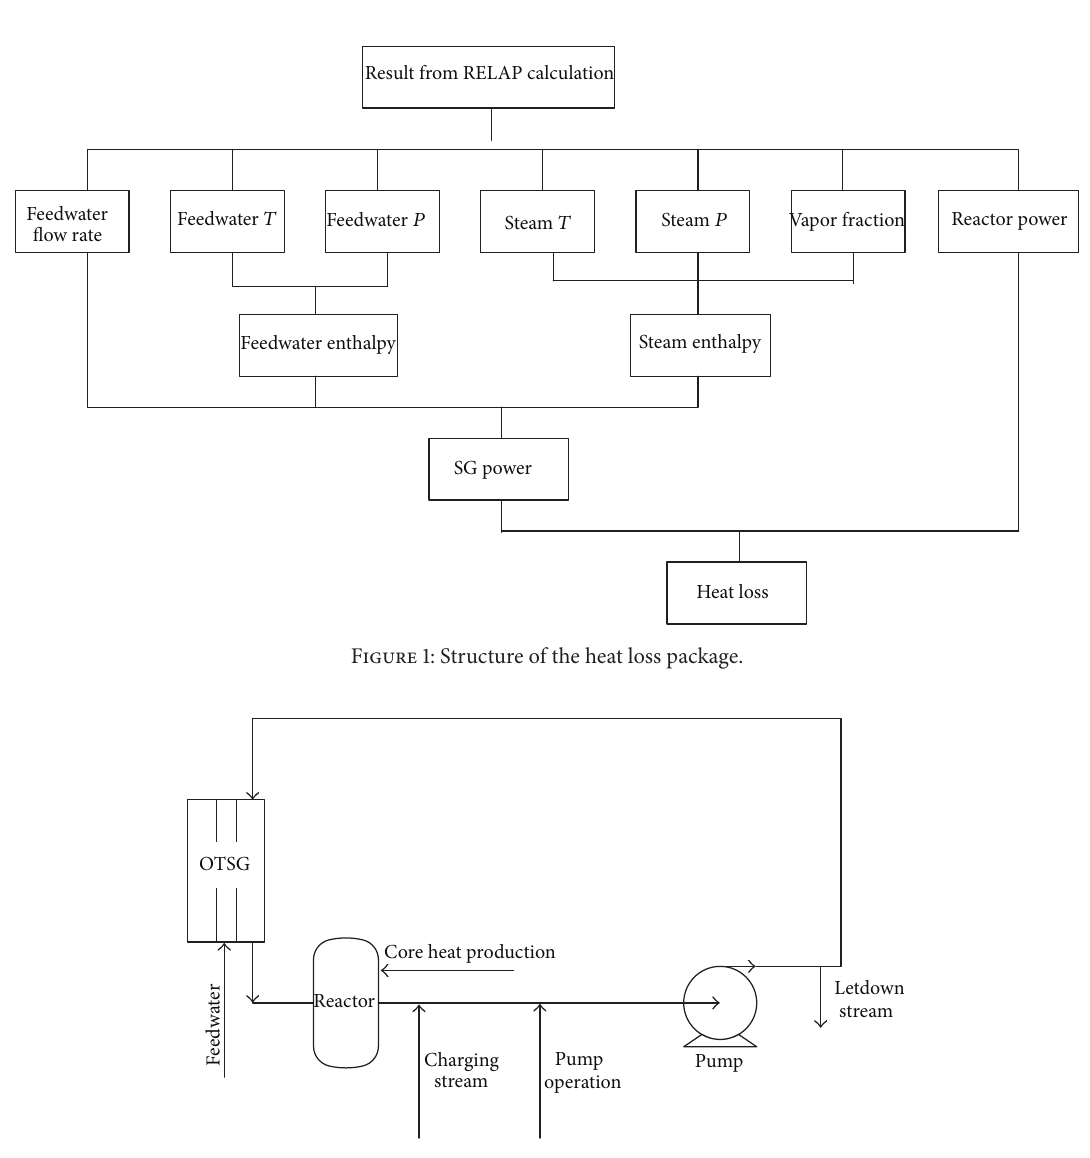
Figure 2: Heat balance principle diagram of